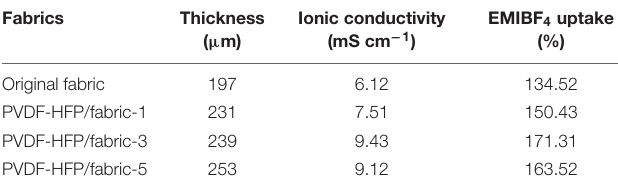
TABLE 2 | Thickness, ionic conductivity and EMIBF 4 uptake of fabric